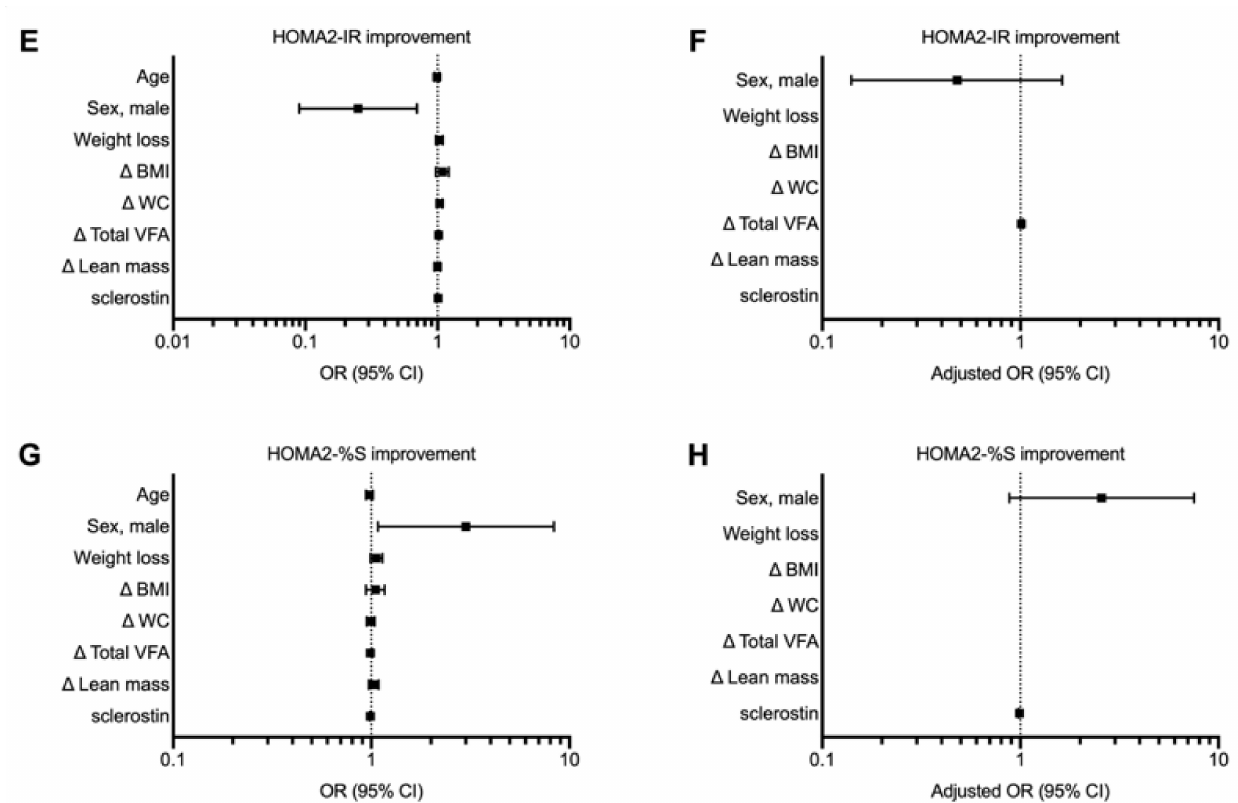
Figure 4. Forest plot illustrating potential determinants of glycemic improvement after sleeve gastrectomy. At univariate— but not adjusted—analyses, baseline values of sclerostin significantly predict glycemic profile improvement assessed by fasting glycemia ( A , B ) and glycated hemoglobin (HbA1c) ( C , D ), but not homeostatic model assessment (HOMA)2 for insulin resistance (IR) ( E , F ). Conversely, the predictive value of serum sclerostin toward an improvement in HOMA2-% for insulin sensitivity (S) was also confirmed at adjusted analysis ( G , H ). Other variables included in the model are body mass index (BMI), waist circumference (WC) visceral fat area (VFA) and lean